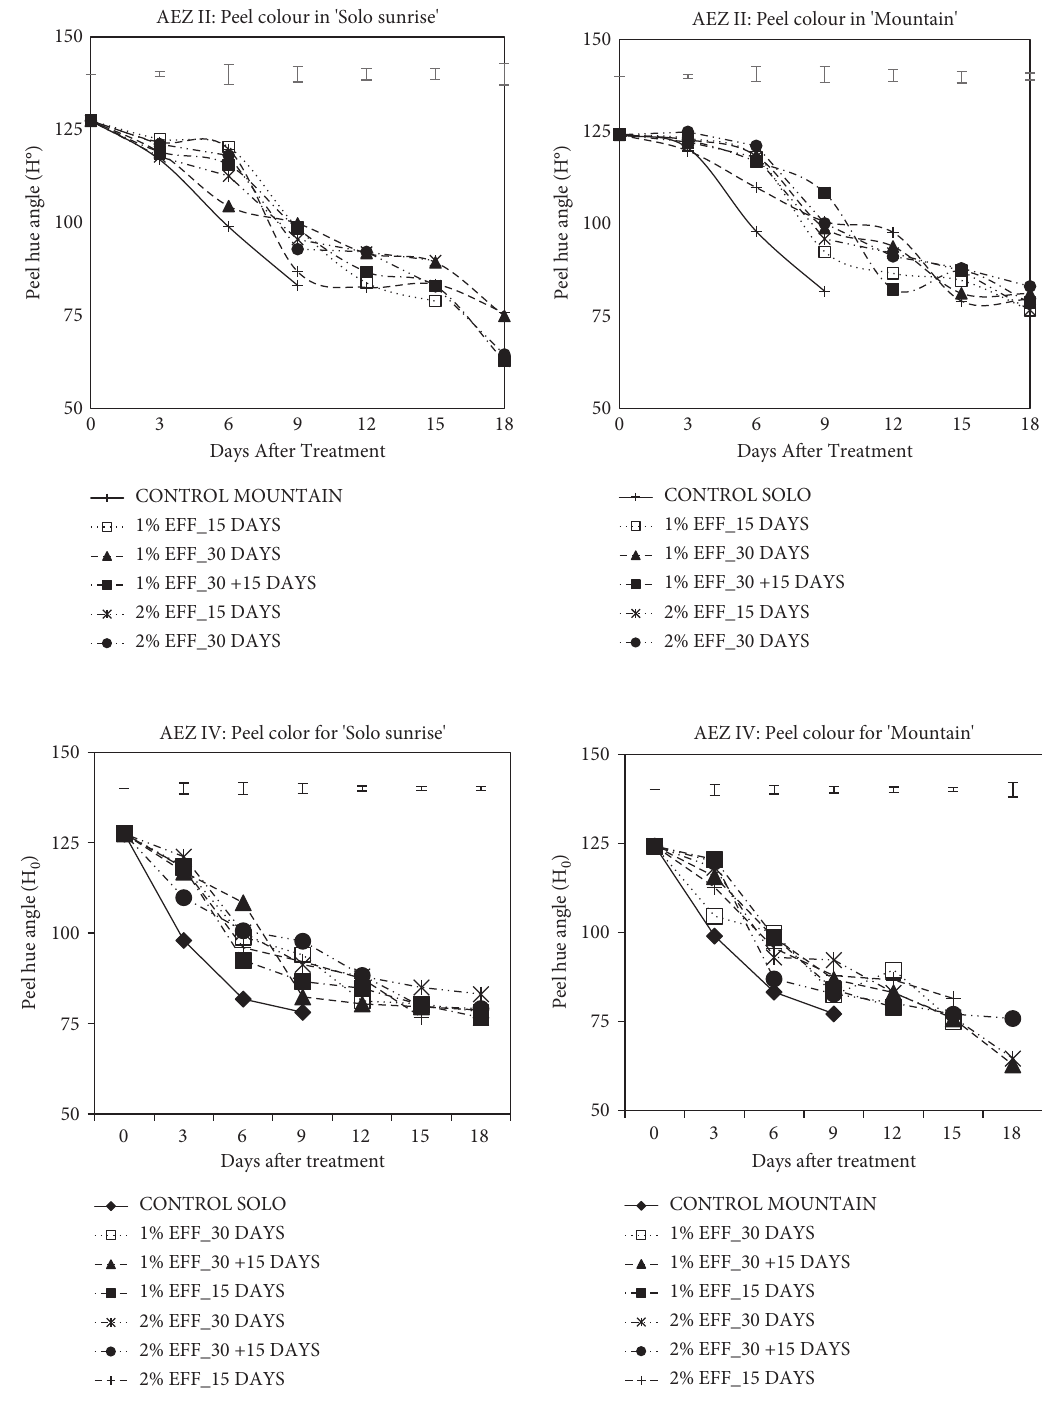
Figure 2: Papaya peel color (H ° ) of Hexanal sprayed fruits from Machakos and Meru counties. Top bars represent LSD at